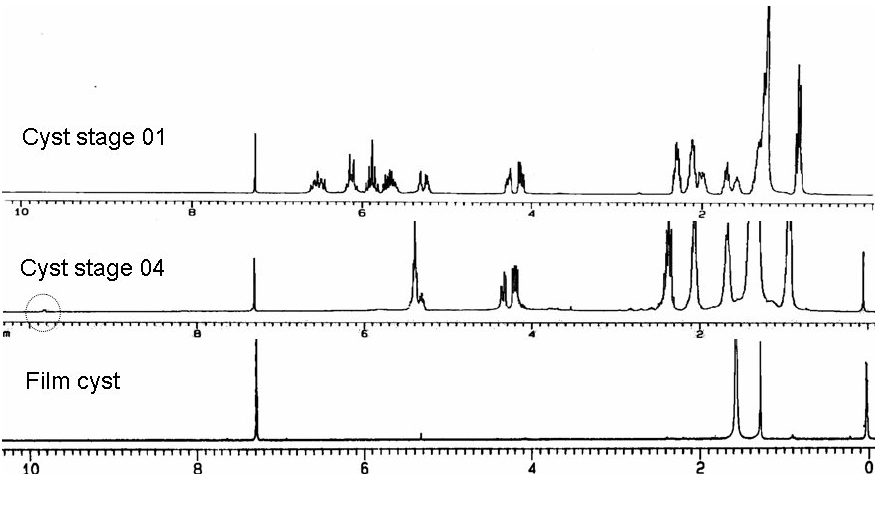
Figure 2 . 1 H-NMR spectra of the cyst, increasing development stages (less to more advanced, 01-04) and external cyst